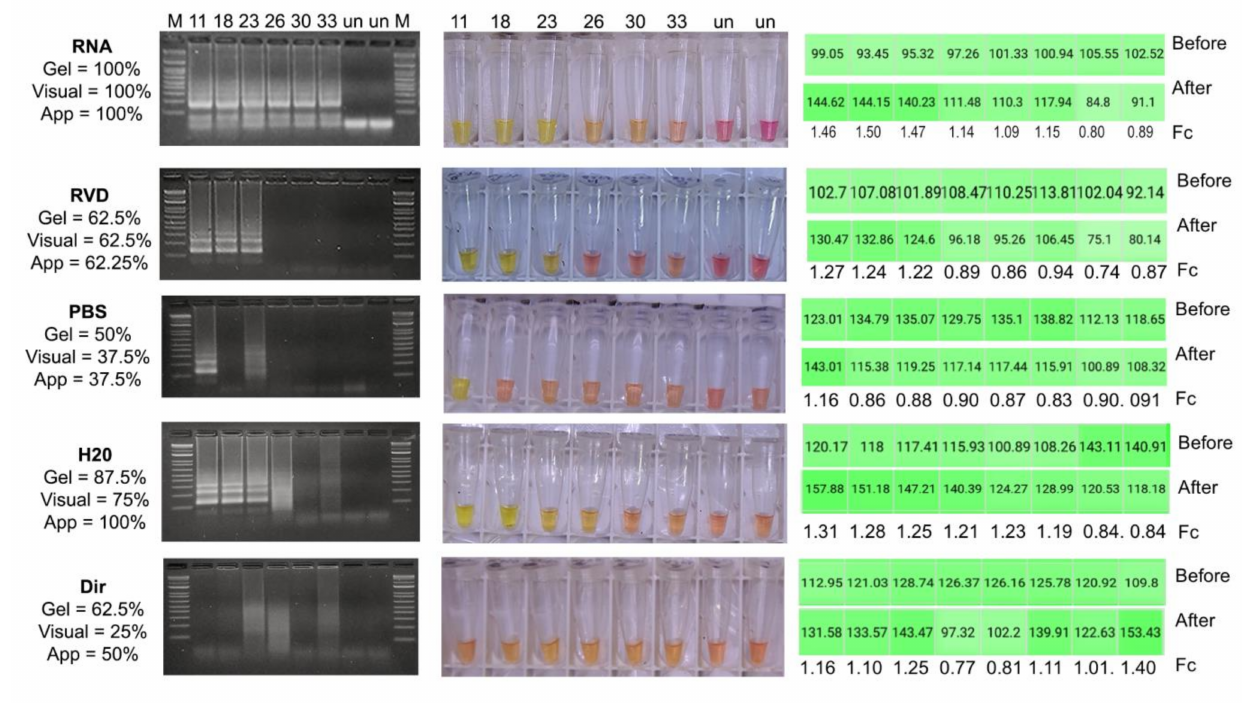
Figure 1. Agreement of sample pre-processing strategies. Percentages in each strategy are values of total agreement, calculated based on results for eight NPSs and four NPAs with Ct from 11–33 plus two negatives of each type of sample (labeled un); for esthetic reasons, only half of the pictures are shown. For all gels: smears were counted as positives, M = 100 pb ladder, numbers 11, 18, 23, 26, 30, 33 = Ct of the sample. For tubes for visual detection: “orangish” was taken as negative, numbers 11, 18, 23, 26, 30, 33 = Ct of the sample. For the application (App): order is for tubes shown for visual detection (Ct 11, 18, 23, 26, 30, 33, un, un), Fc (fold change) = after/before; if Fc > 1.0, the sample was classified as positive.